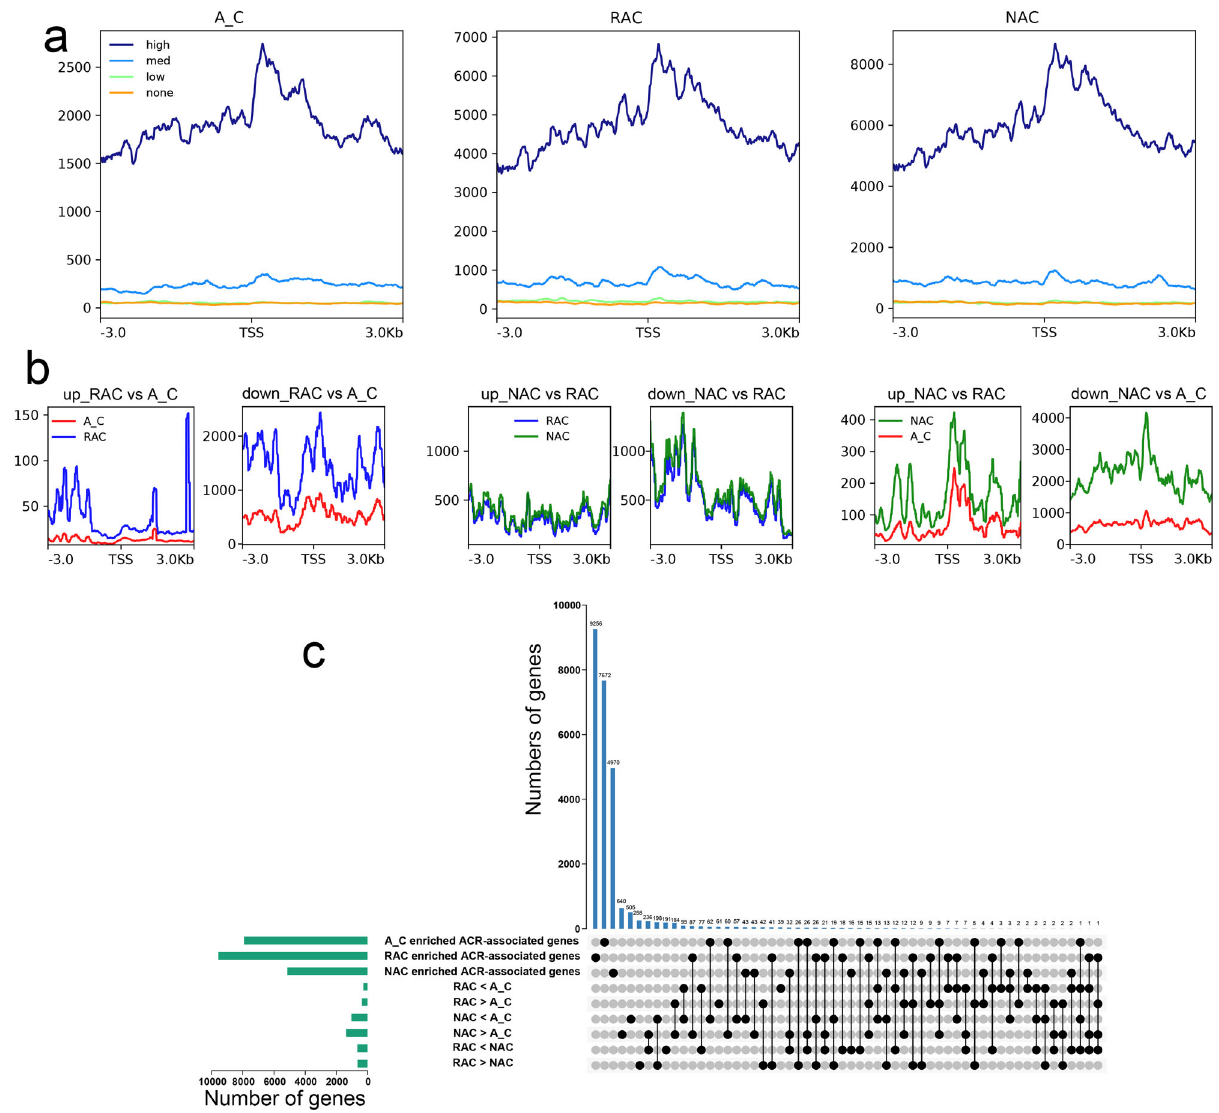
Fig. 3 The relationship between chromatin accessibility and gene expression level. a Chromatin accessibility of genes with different expression levels. High, highly expressed genes (TPM greater than 10); med, moderately expressed genes (TPM between 1 and 10); low, lowly expressed genes (TPM greater than 0 and less than 1); none, silenced genes (TPM equal to 0). b Chromatin accessibility of DEGs. DEGs, genes with |log 2 fold change | ≥ 1 and adjusted P value ≤ 0.001. c Overlap of genotype-enriched ACR-associated genes and DEGs. Genotype-enriched ACR-associated genes, genes related to genotype- speci fi c ACRs and ACRs with ACR that had a fold change ≥ 2. A_C, in silico ‘ hybrid ’ ; RAC, resynthesized B. napus ; NAC, natural B. napus ; TSS, transcript start site; ACRs, accessible chromatin